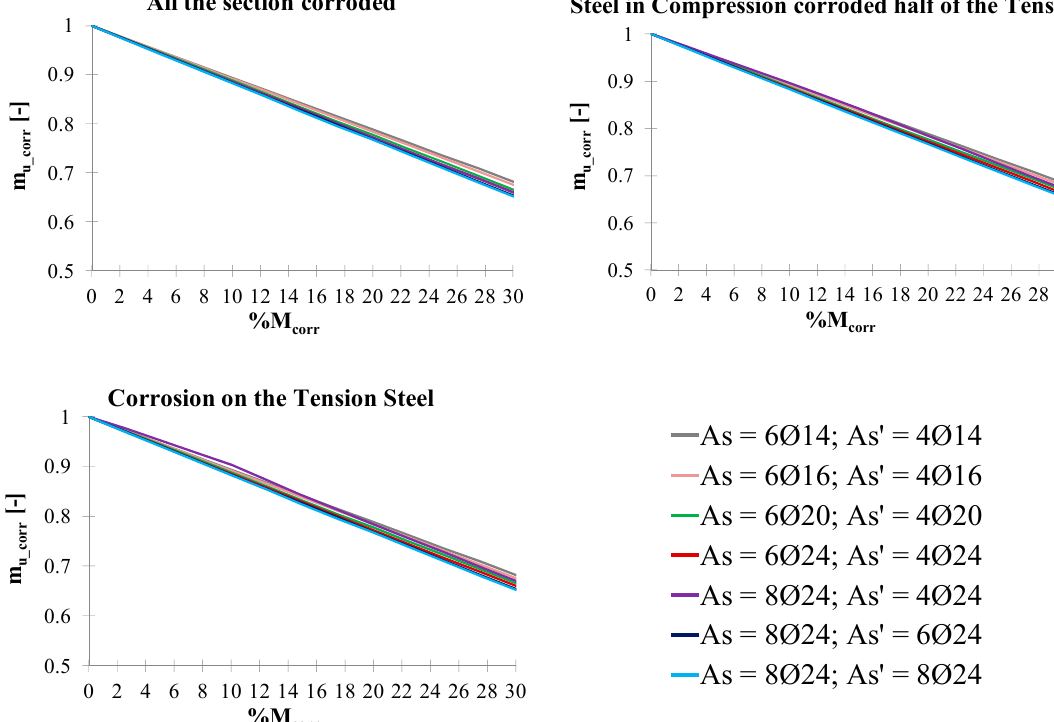
Figure 7. Nondimensional ultimate bending moment for different corrosion scenarios—flat Beam, uniform corrosion.